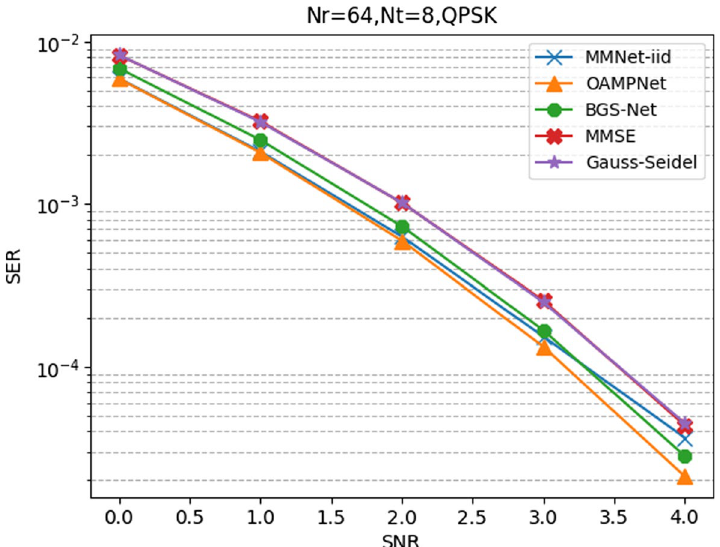
Fig. 14 SER performance comparison of different algorithms under N t = 8,N r = 64 , QPSK, SAUE